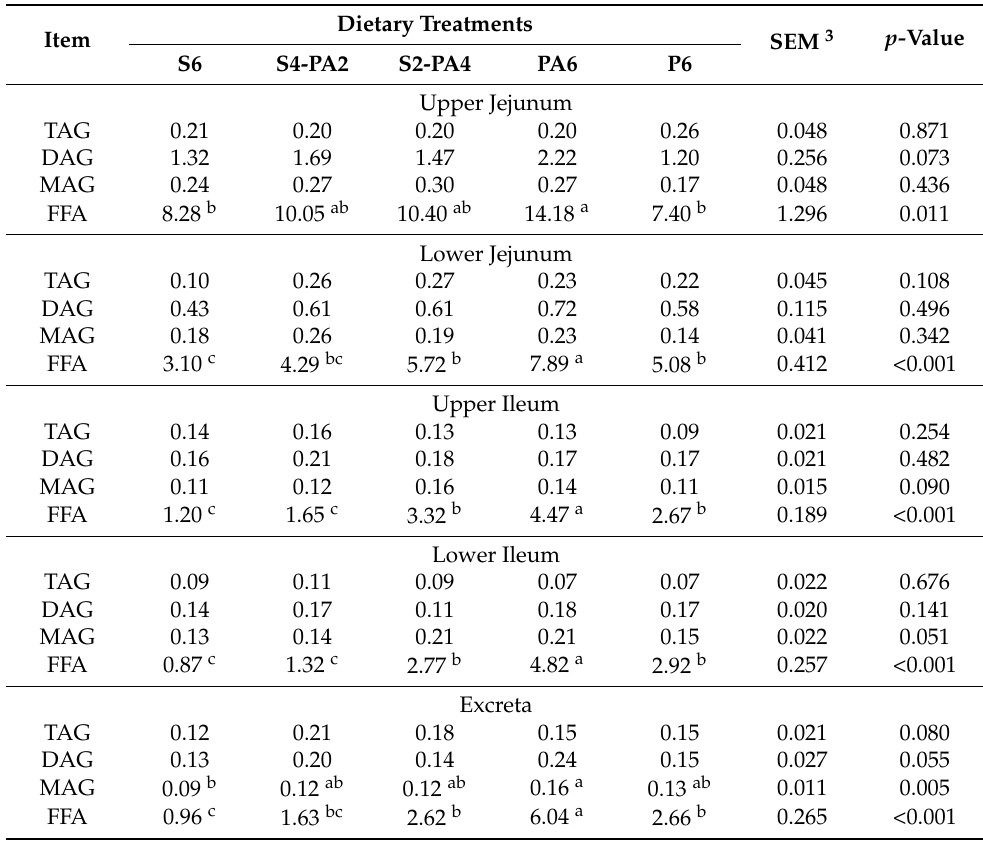
Table 6. Lipid-class content 1 along the intestinal tract and excreta according to different fat sources in the diet 2 in 35-d-old broiler